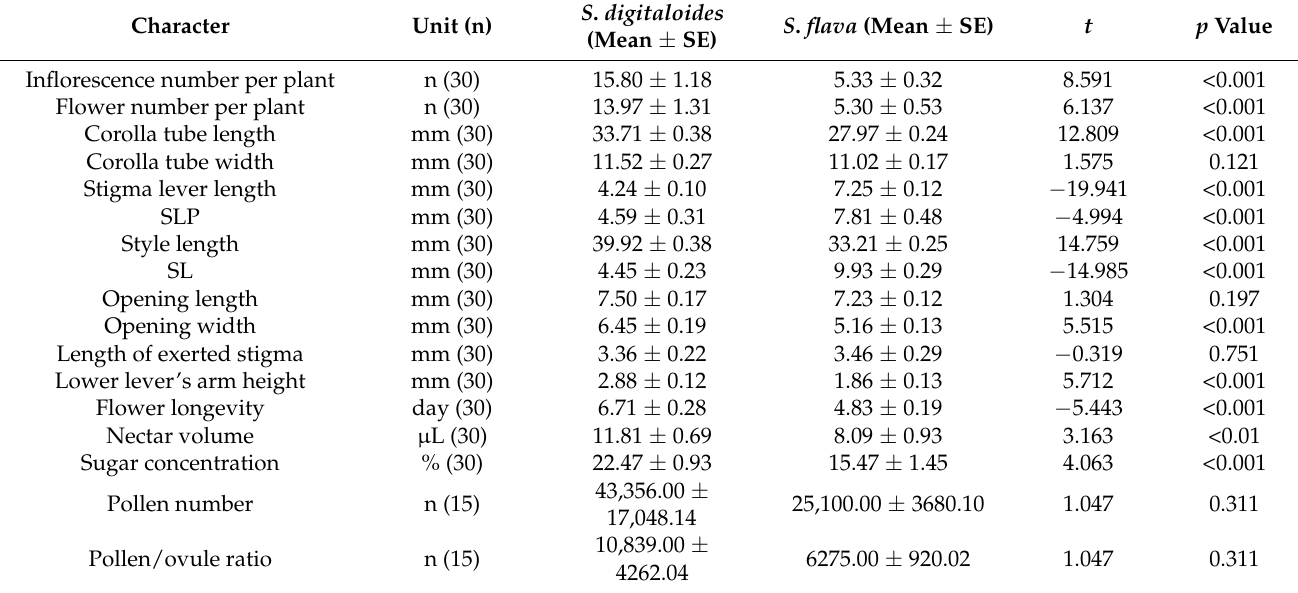
Table 3. Floral trait measurements in Salvia digitaloides and S . flava .